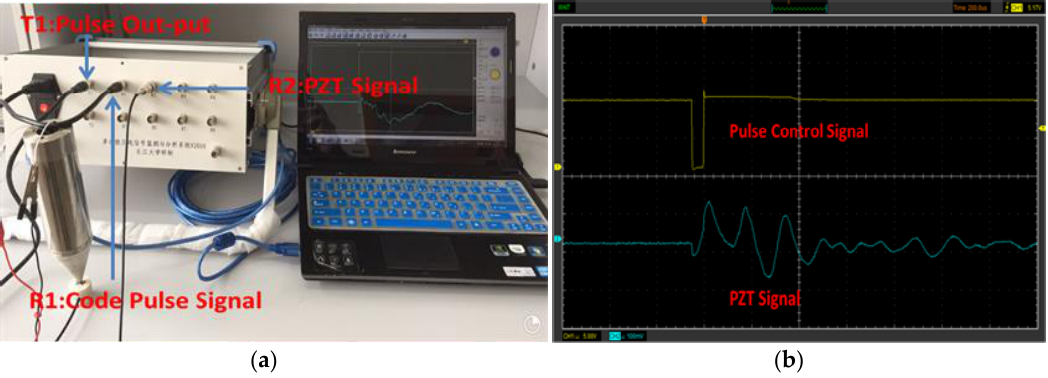
Figure 6. Pulse stress signal test. ( a ) Instrument setup for generating pulse signal; ( b ) Generated pulse signal waveform.